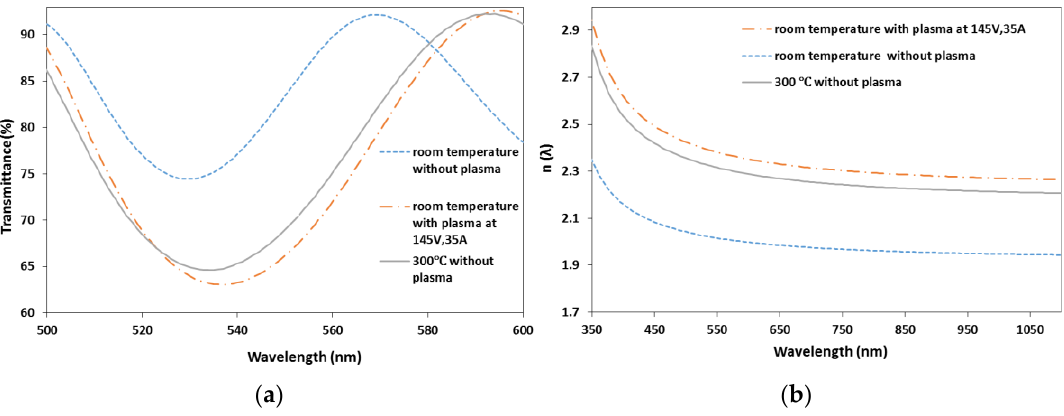
Figure 6. ( a ) Spectral transmittance of TiO 2 optical thin films deposited at room temperature and 300 °C substrate temperatures (no plasma ion-assisted deposition) and plasma ion-assisted deposition (current = 35 A, voltage = 145 V) at room temperature. ( b ) Shows n (λ) dispersive characteristics for the three deposition scenarios shown in ( a ).